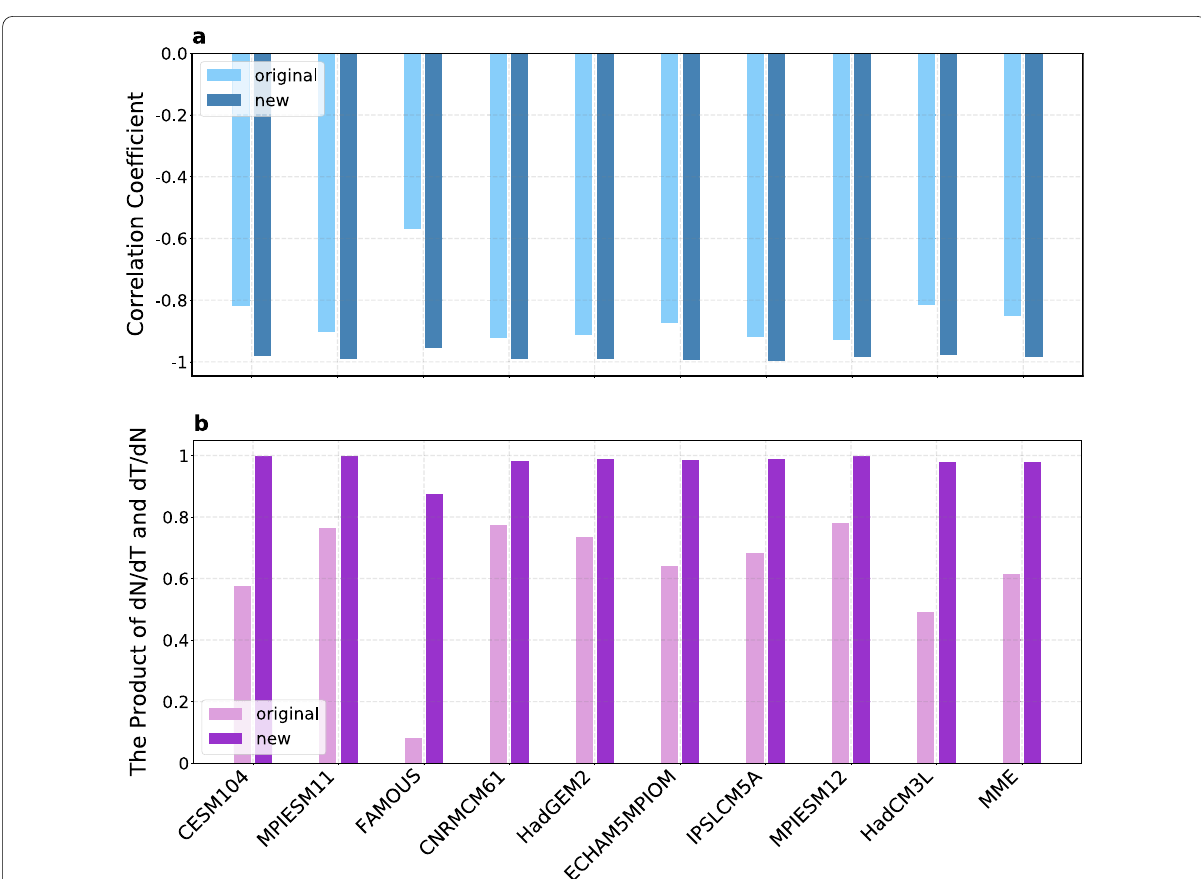
Fig. 3 a The correlation coefficient between the global-mean and annual-mean surface temperature anomalies (cid:31) T and TOA net radiative flux anomalies (cid:31) N in the abrupt4xCO2 experiments (relative to the piControl run) of LongRunMIP models. b The product of d N /d T (slope of the linear fit between (cid:31) T and (cid:31) N ) and d T /d N (slope of the linear fit between (cid:31) N and (cid:31) T